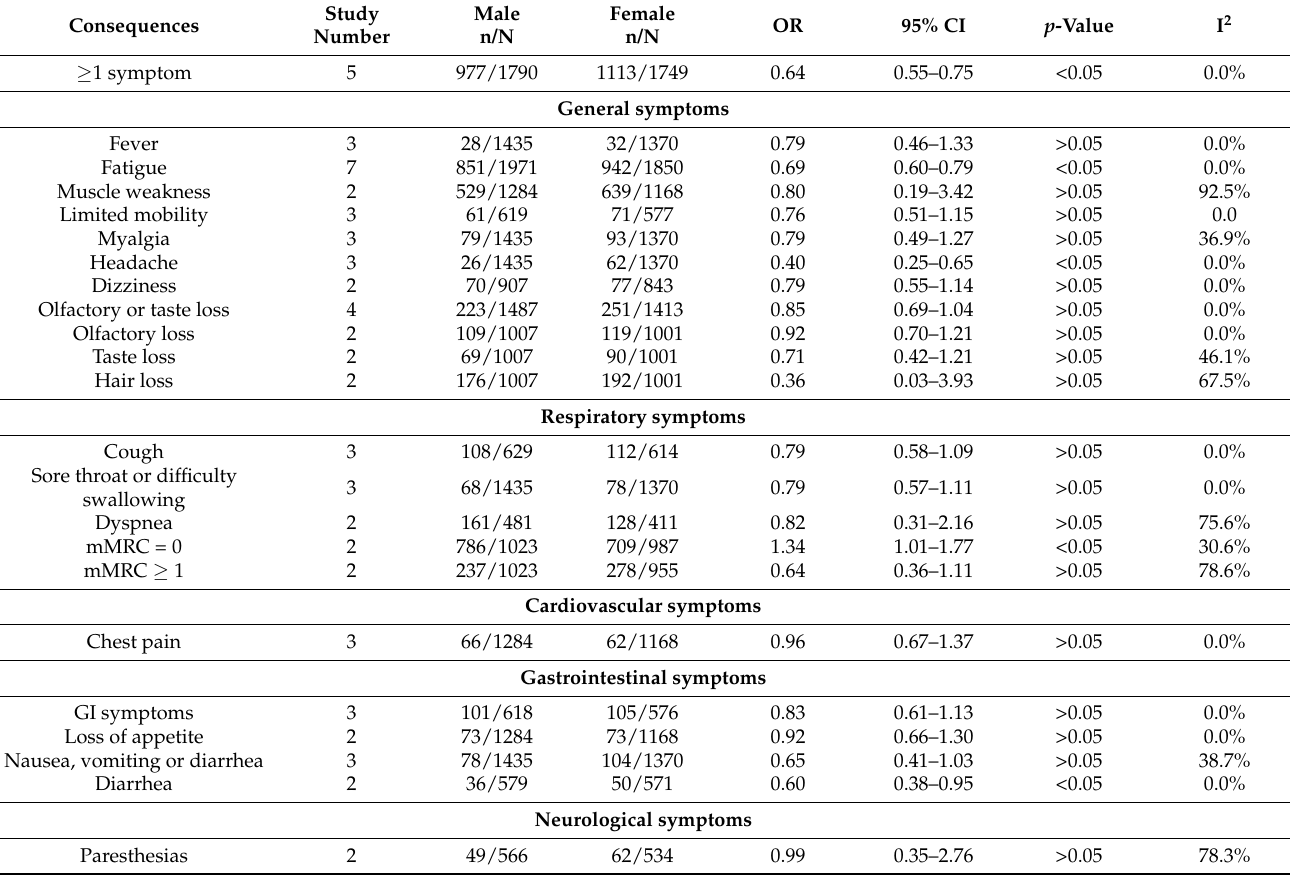
Table 2. Gender differences in consequences of long-term